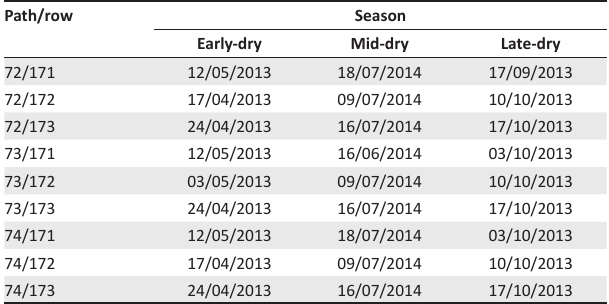
TABLE 1-A1: Images used for creating study area mosaics. Path/row